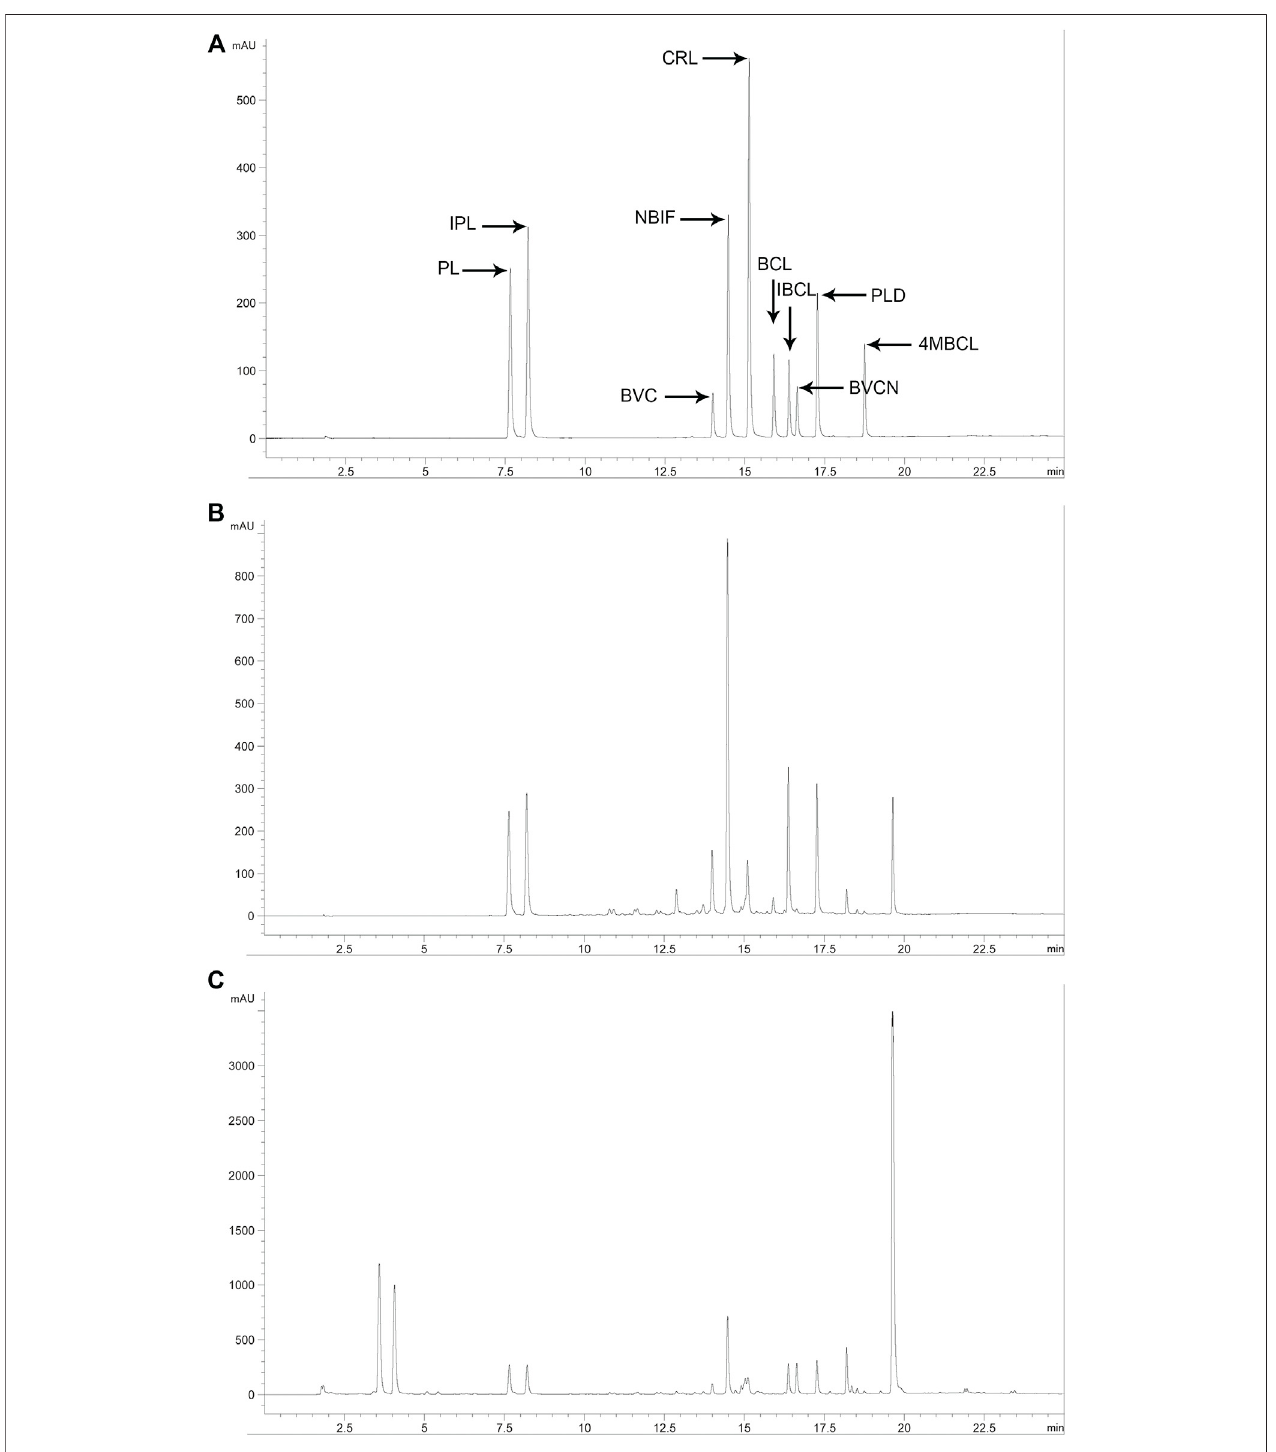
FIGURE 2 | HPLC chromatogram of related standard compounds ( (A) standard mixture at 50 μ g/ml), PFPE ( (B) 1 mg/ml), and PF ( (C) 10 mg/ml) at 254 nm.